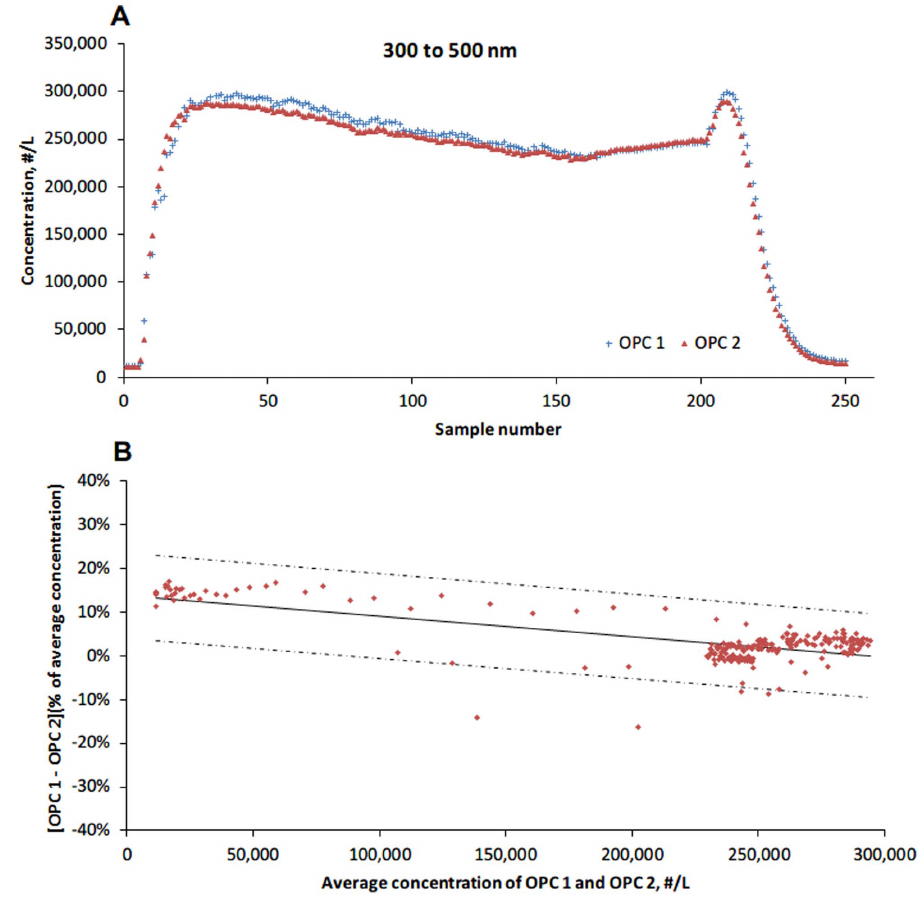
Particle size range, nm All sizes 300 to 500